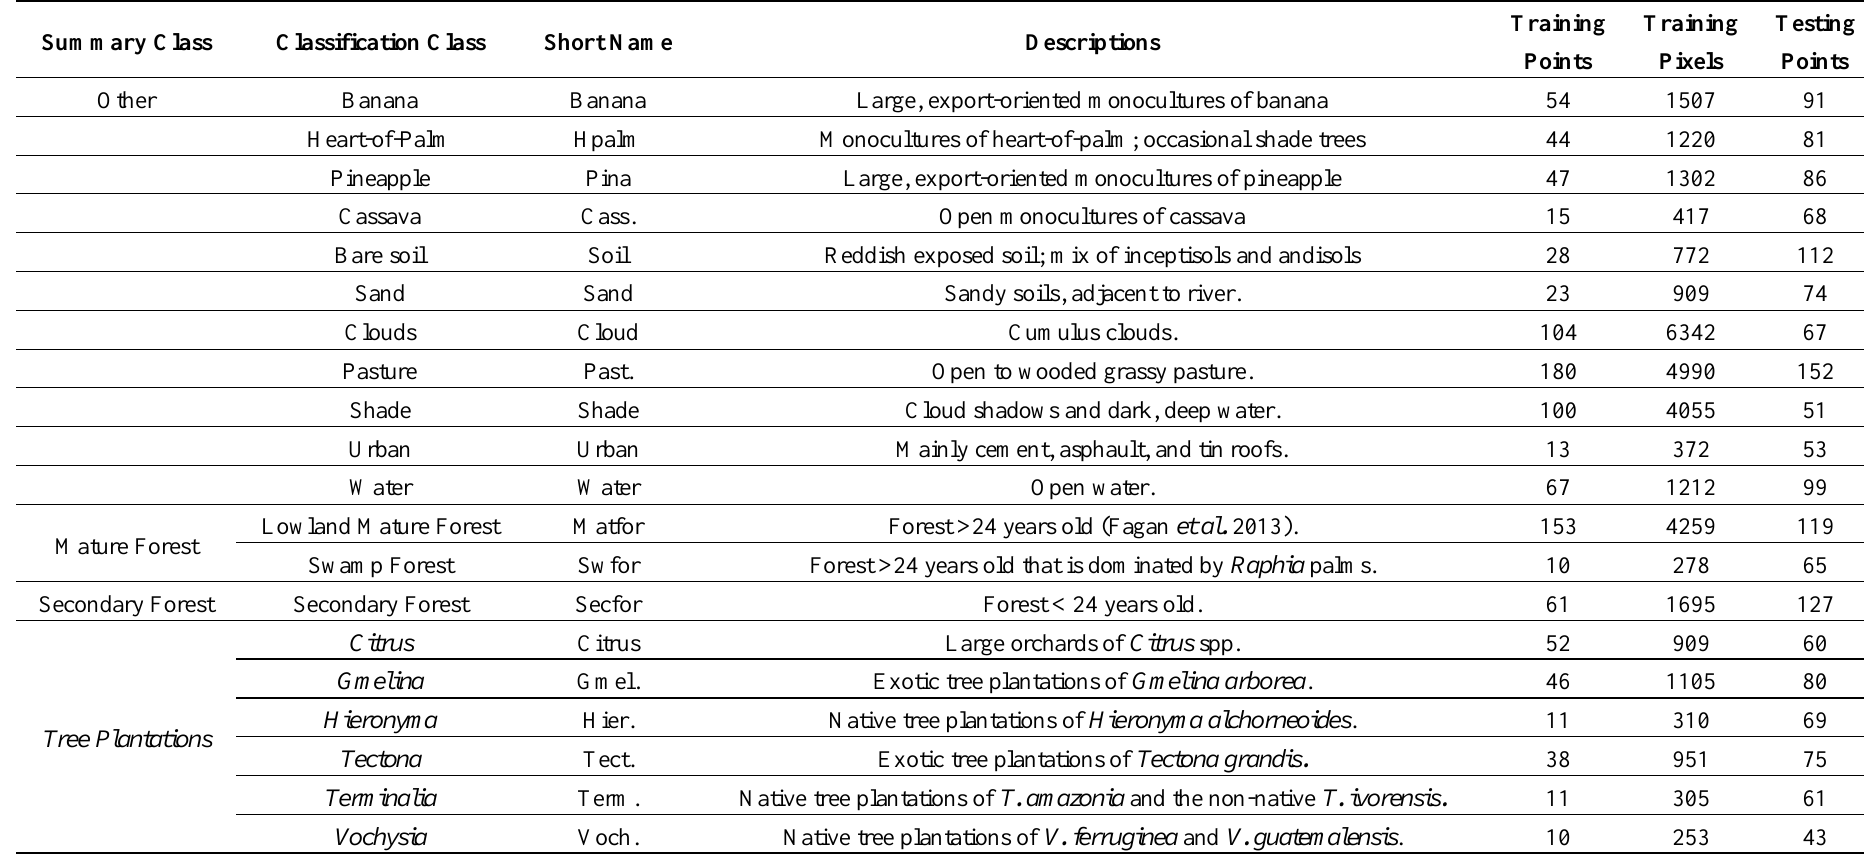
Table 2. Class information and descriptions for the land-use classes in this study. The classification class was used for the initial model classification and map prediction, and the summary class was used for comparisons of the Random Forest models. Tree plantations were assessed both as a grouped class and as separated class ( i.e ., each species) in the final summary accuracy assessment, and so are marked in italics. Classes referred to as reforestation in the text are in bold, and include secondary forests and tree